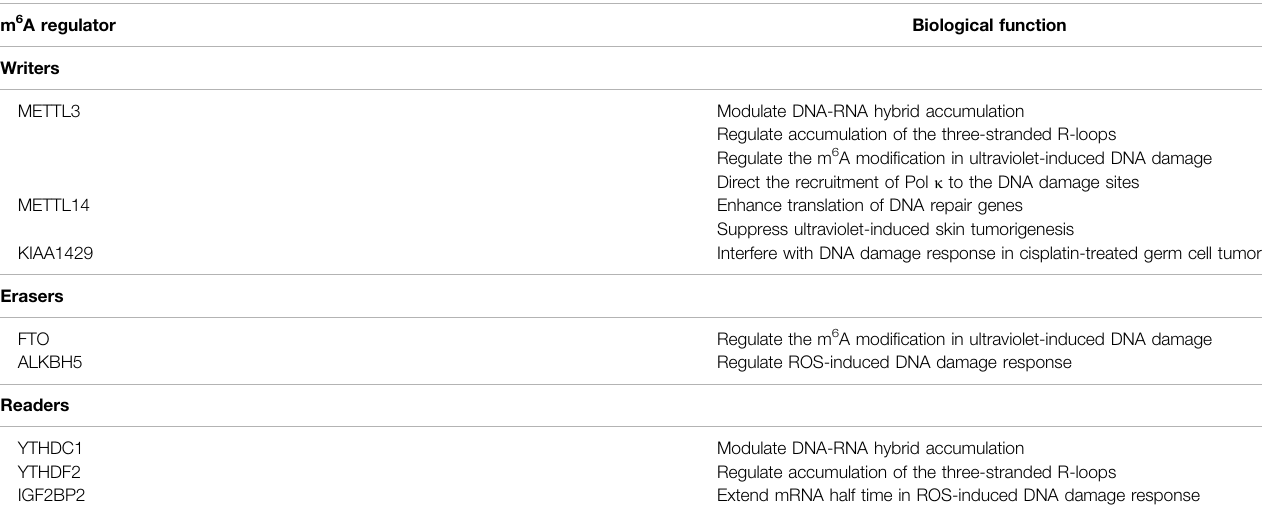
TABLE 2 | m 6 A-associated proteins in DNA repair.